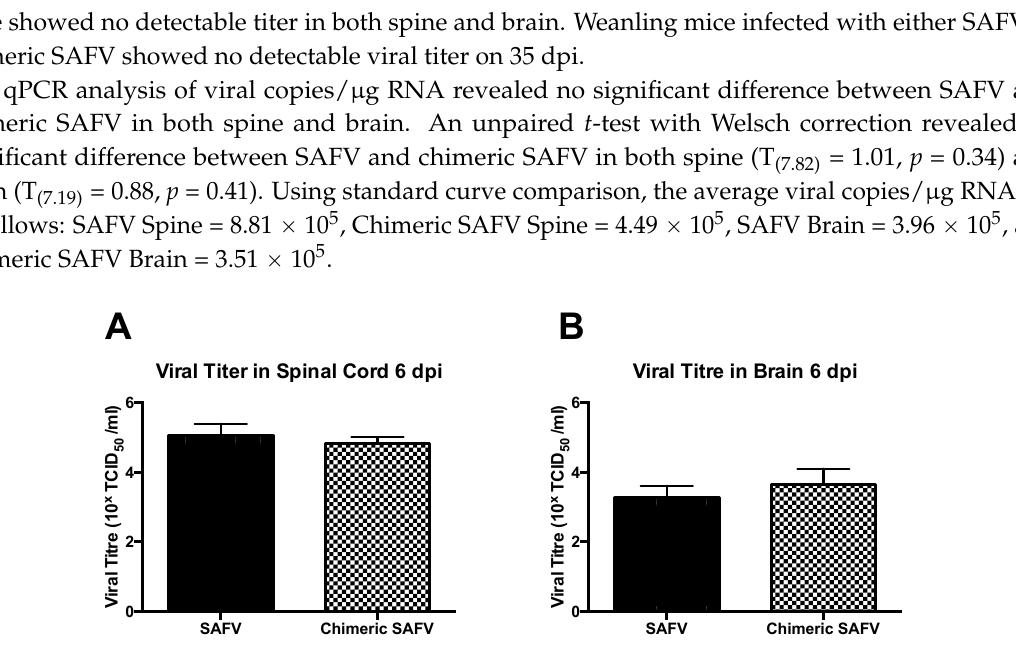
Figure 4. Virus titers in CNS 6 dpi. Data presented in mean + SEM. Two-week-old AG129 was infected